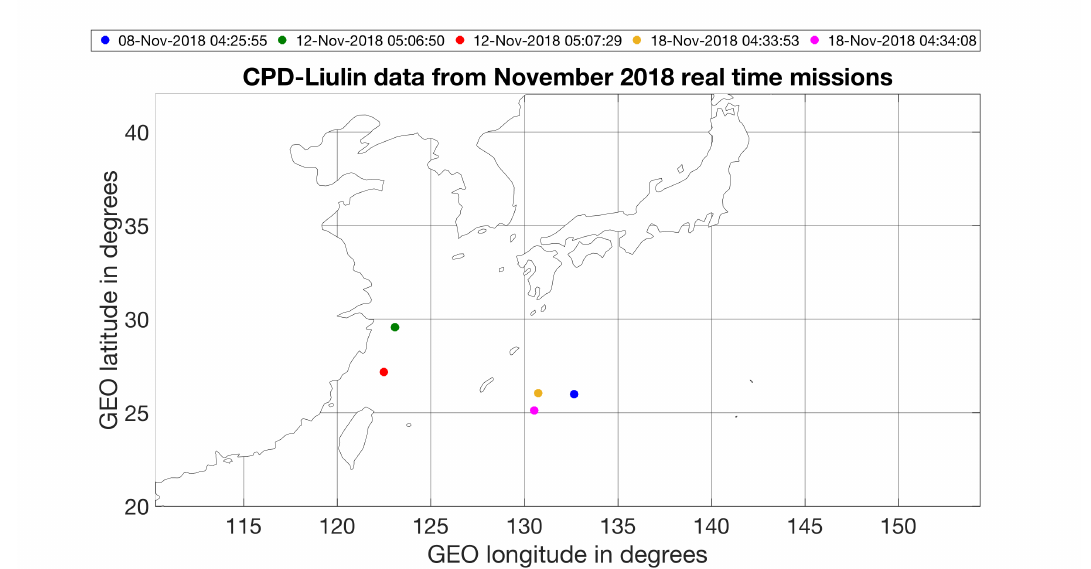
Figure 12. Geographic locations of the CPD missions conducted on November